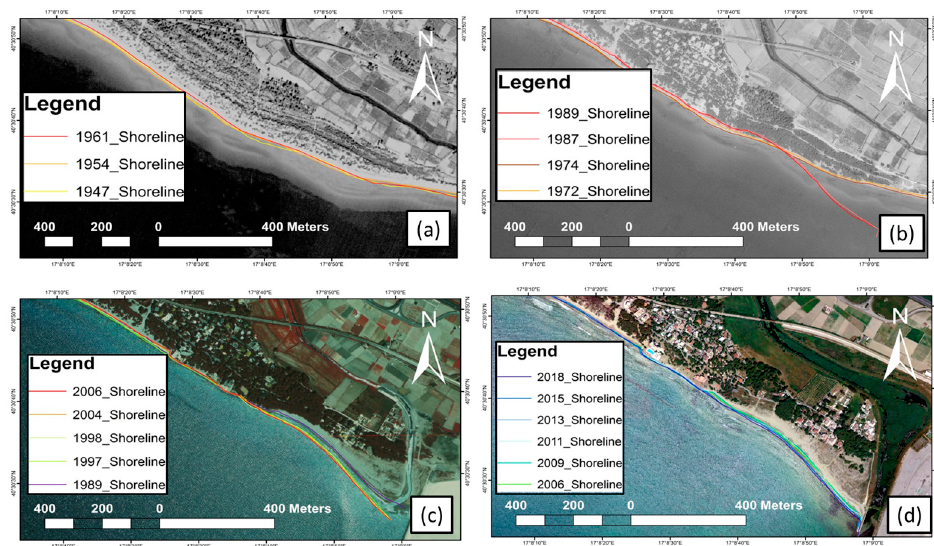
Figure 11. Shoreline changes close to the Tara River mouth: ( a ) 1954 basemap with 1947–1961 super-imposed shorelines; ( b ) 1974 basemap with 1972–1989 super-imposed shorelines; ( c ) 1989 basemap with 1989–2006 super-imposed shorelines; and ( d ) 2013 basemap with 2006–2018 super-imposed shorelines.